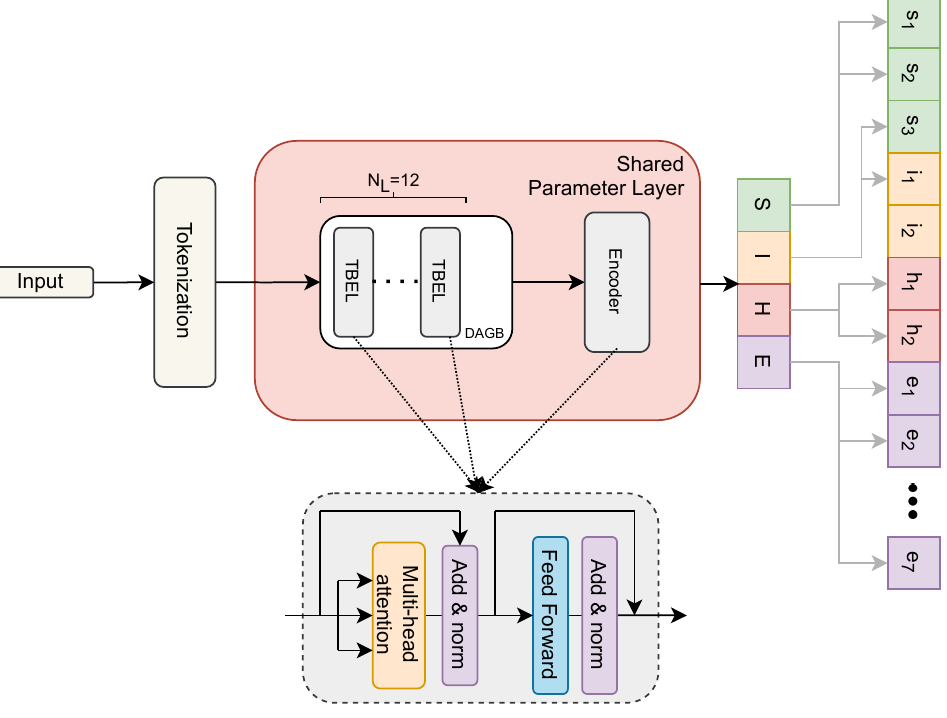
Figure 1. Architecture overview of our proposed parameter-shared intelligent media analytics framework. S, I, H, and E denote the sentiment, irony, hate speech, and emotion classification heads, respectively,and DAGB and TBEL denote the domain-adapted Greek BERT language model and the transformer-based encoder layer, respectively. N L denotes the number of encoder